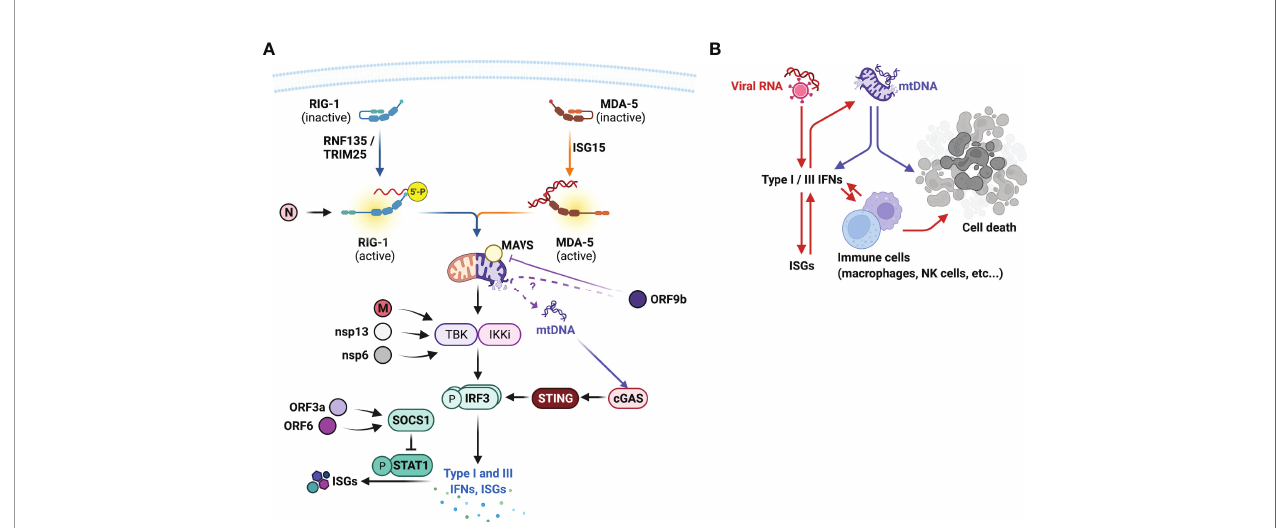
FIGURE 5 | SARS-CoV virulence factors, their targets in the host and type I interferonopathies. (A) SARS-CoVs encode numerous viral factors that directly reduce the hosts antiviral responses. Nucleocapsid (N) protein inhibits RIG-I activation, matrix (M), non-structural protein (nsp)13, and nsp6 impairs TANK binding kinase (TBK1) activation, thus impairing the production of type I and III IFN expressions. Open-reading frame (ORF)3a and ORF6 targets suppressor of cytokine signalling (SOCS)1 that negatively regulates signal transducer and activator of transcription (STAT)1 activation. ORF9b inhibits MAVS activity, suppressing RIG-I